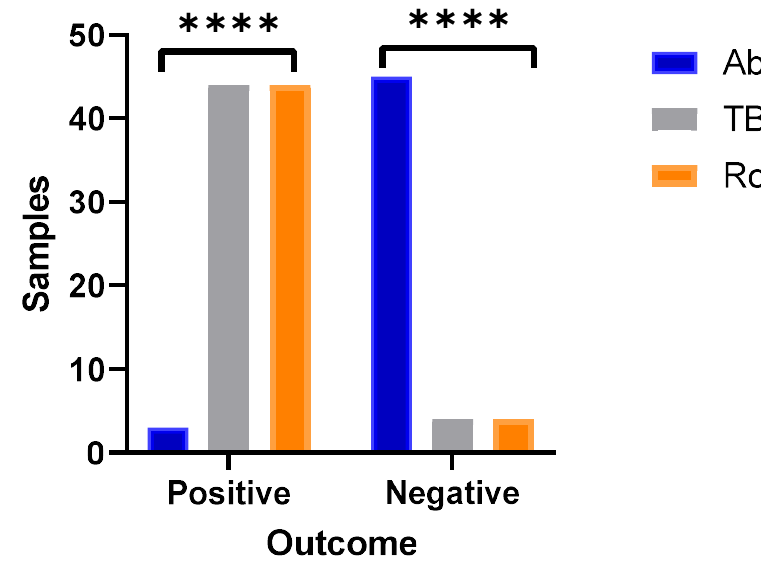
Figure 2. Three-way method comparison between Abbott, TBS, and Roche. Bar graph portrays SARS-CoV-2 antibody outcomes produced by Roche in the discordant sample set (n = 48) between Abbott and TBS. Statistically significant differences observed from outcomes generated by Abbott versus Roche and TBS (**** = p < 0.0001, Chi-square test). Outcomes produced by both TBS and Roche are identical to each other (100% concordance).